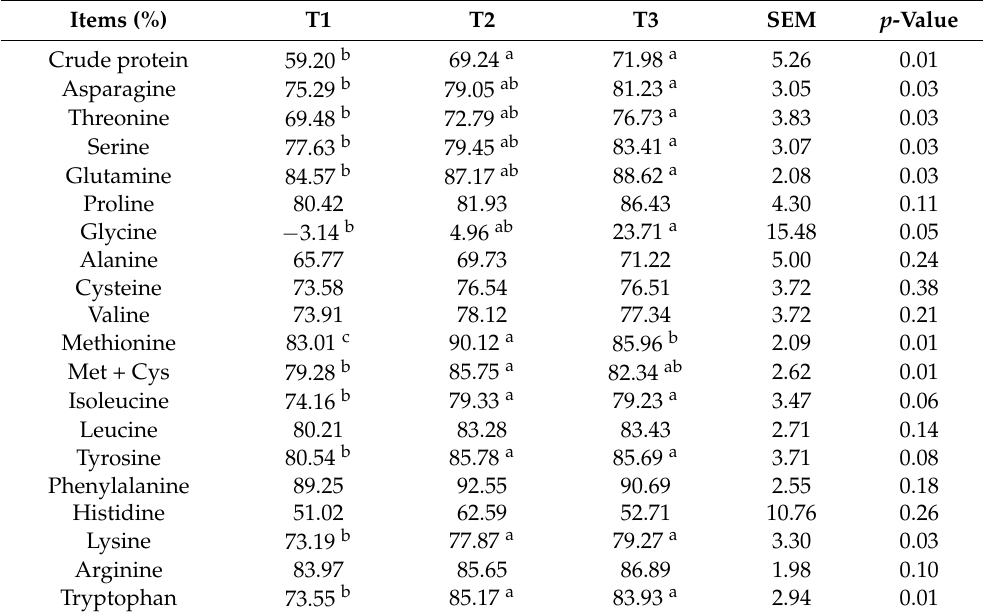
Table 7. Effects of fructooligosaccharides on apparent fecal amino acid digestibility of laying hens. Items (%)